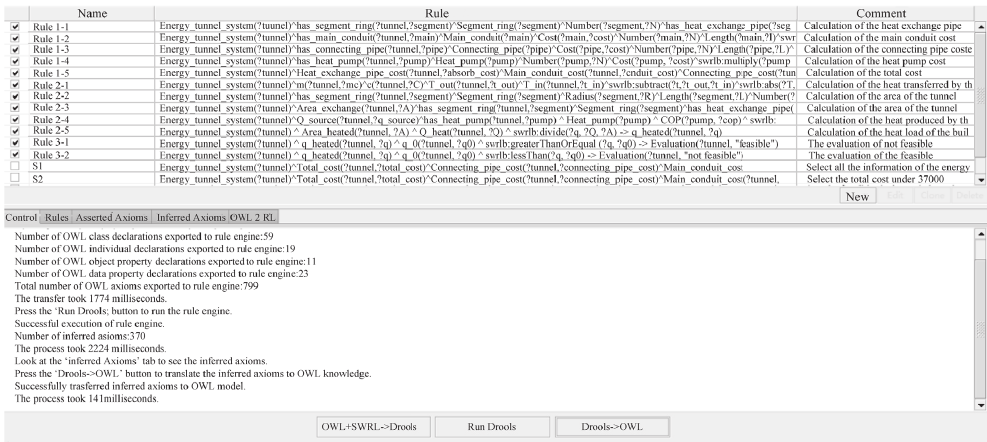
Figure 7: Execution log of rule